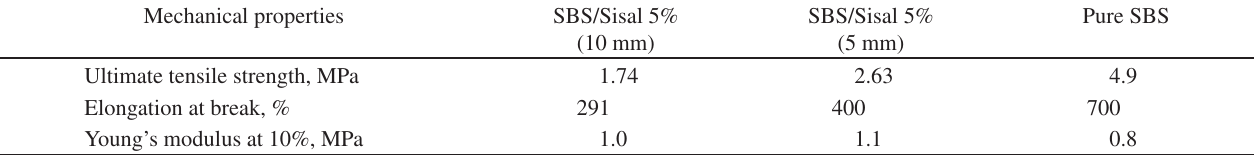
Table 3. Ultimate tensile Strength, Elongation at break and Young’s modulus at 10% of SBS/sisal and pure SBS processed in a single screw extruder. Mechanical properties